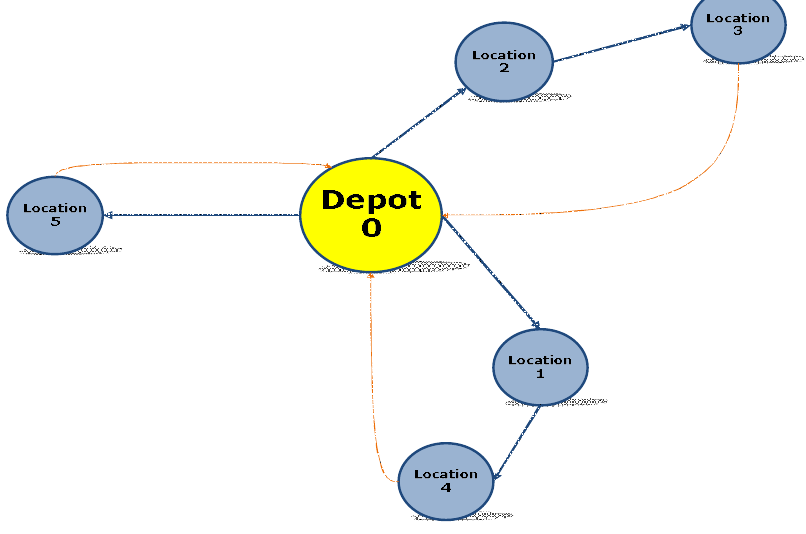
Fig. 5. Route Structure for Optimized Scenarios (Scenario